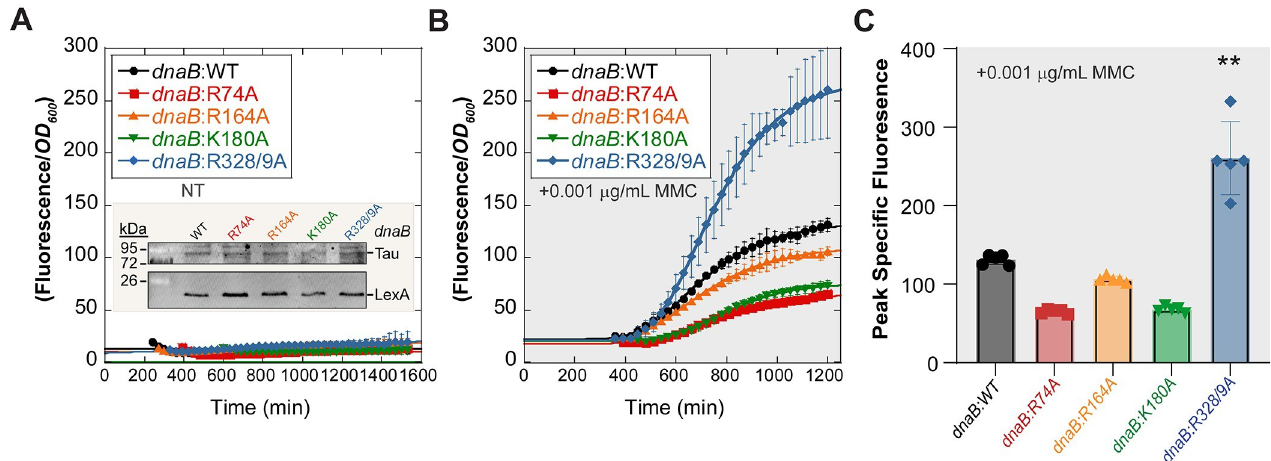
Fig 7. The SOS response is not significantly induced in the dnaB : mut strains. Specific fluorescence for dnaB strains grown ( A ) in LB with no exogenous treatment (NT) or (B) with low dose mitomycin C (0.001 μ g/mL), each containing a plasmid expressing GFP under a recN promoter to monitor SOS induction. An inset in ( A ) shows a western blot of stable LexA expression in all dnaB : muts in NT conditions. Specific fluorescence is defined as the measured fluorescence divided by the optical density ( OD 600 ) to control for growth. Due to the error inherent in dividing very small numbers, specific fluorescence is not shown during lag phase. ( C ) The maximum fluorescence from B is plotted for comparison between strains ( Eq 7 ). Error bars represent ± SD and are within symbols where not visible. Statistically significant differences are indicated where p-values are �� <